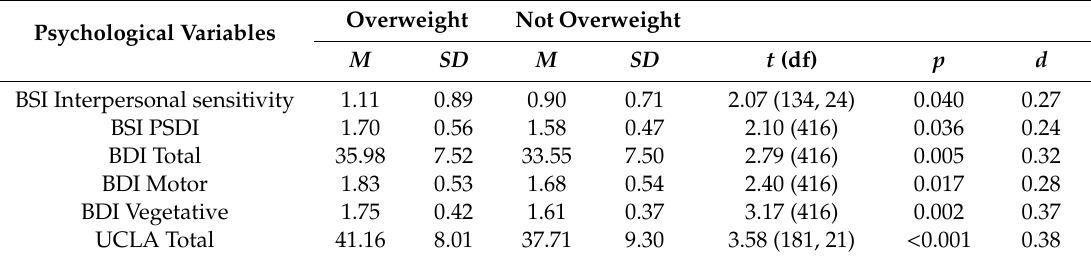
Table 11. Significant means di ff erences of